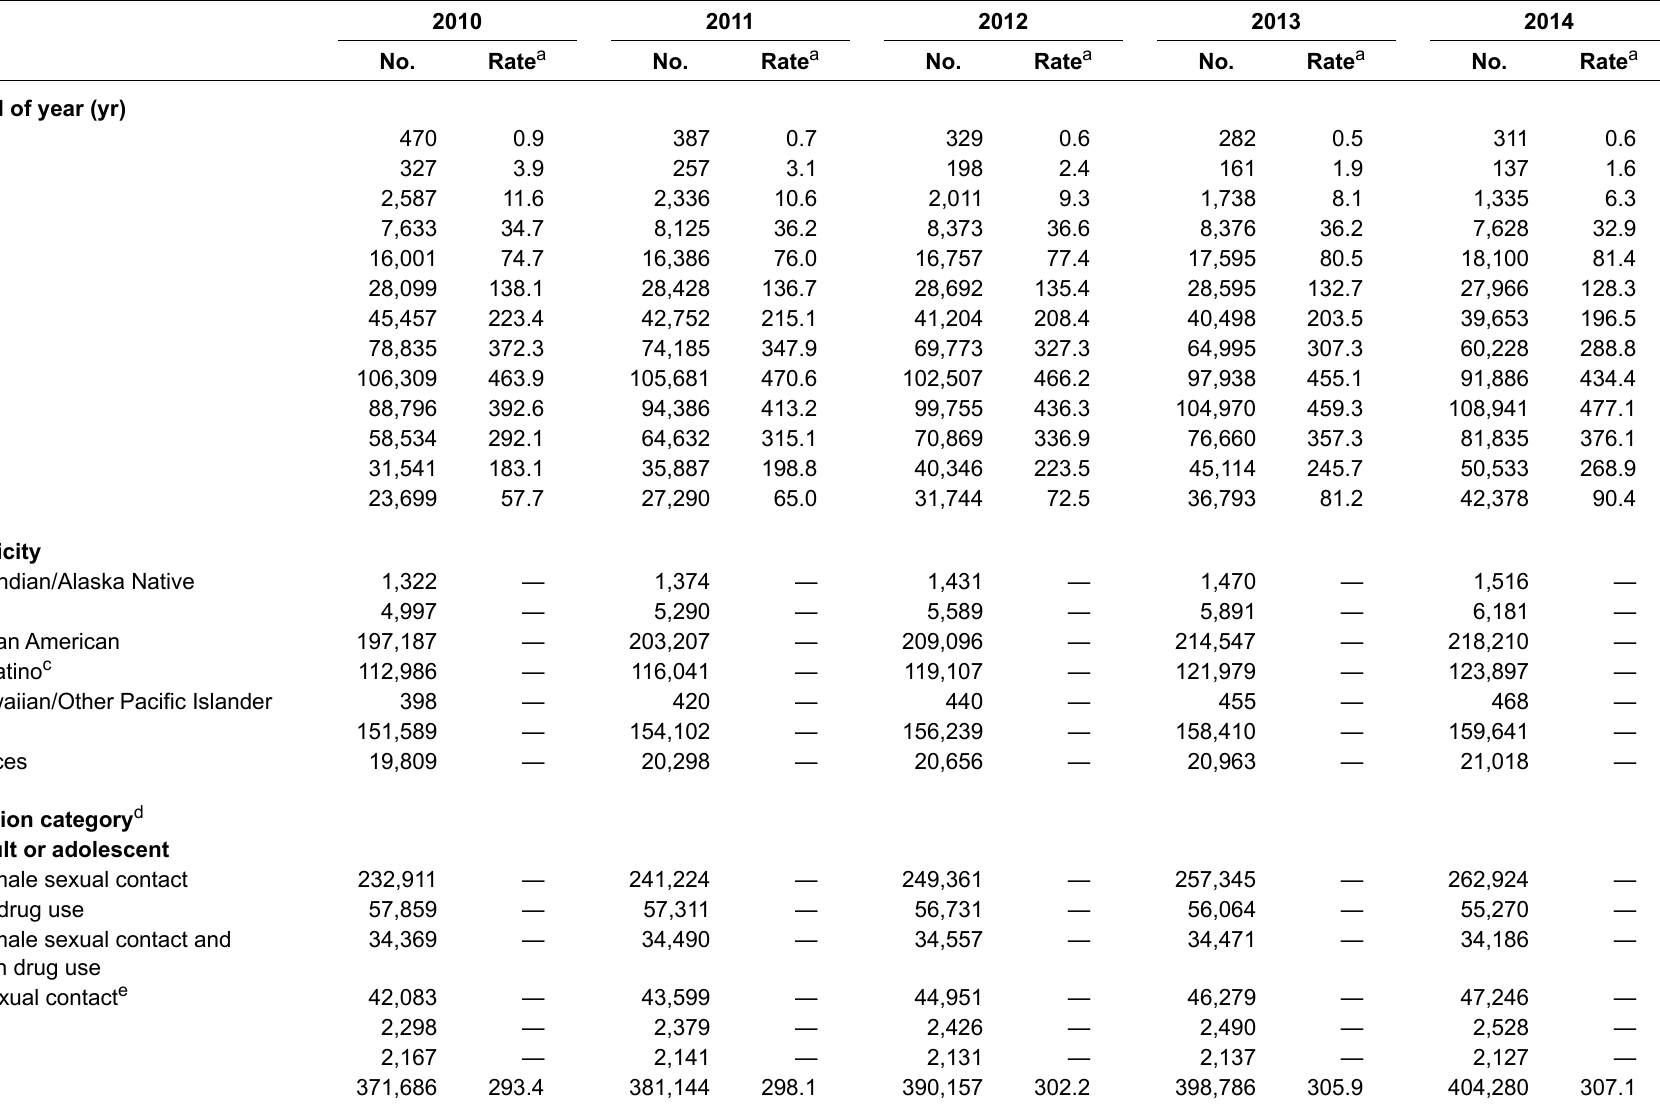
Table 19b. Persons living with diagnosed HIV infection ever classified as stage 3 (AIDS), by year and selected characteristics, 2010–2014—United States